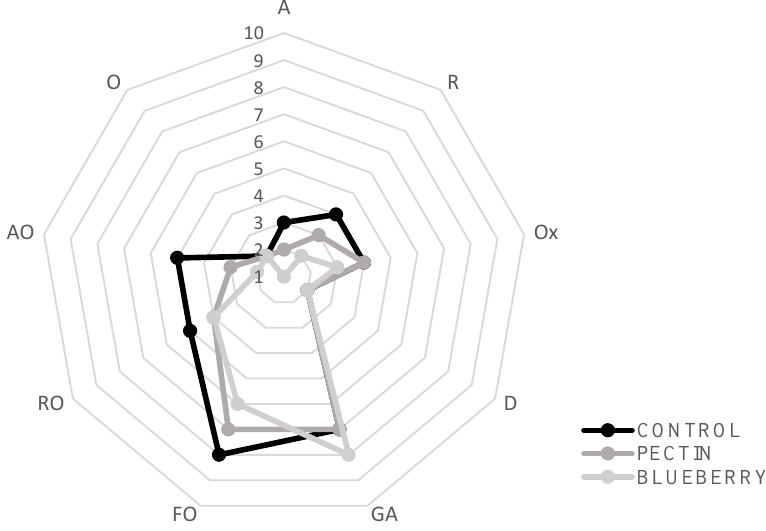
Figure 4. Sensorial analysis on day 2. Aromatic (A), rot (R), oxidation (Ox), dehydration (D), general acceptability (GA), fishy odor (FO), rancid odor (RO), ammonia odor (AO), and others (O).